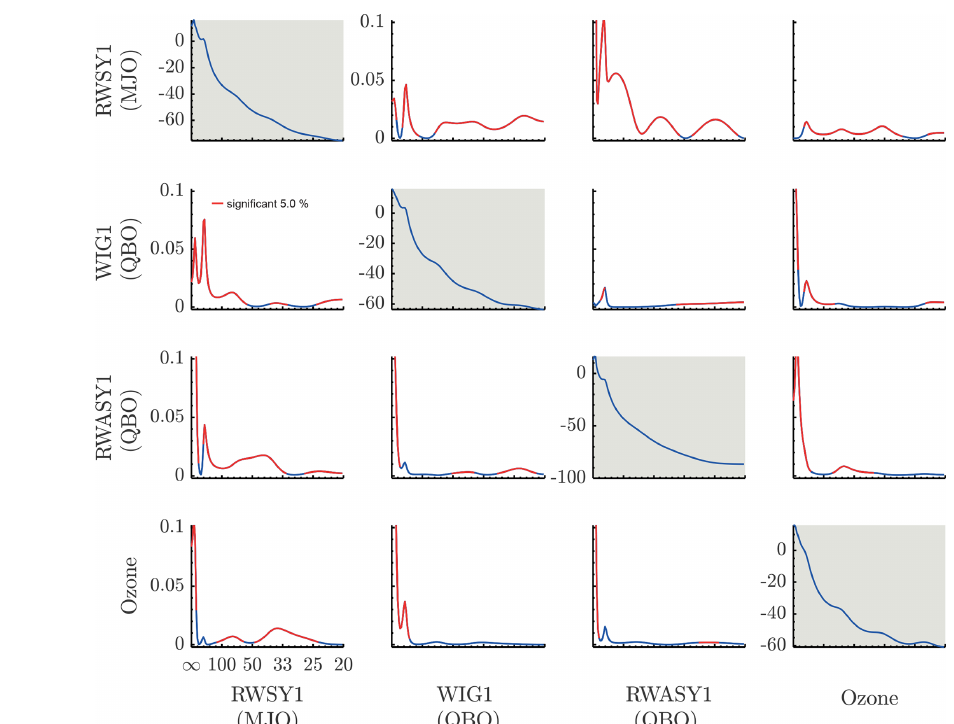
Figure 4. PDC analysis of the interaction of Kelvin, asymmetric Rossby, and westward gravity modes with ozone at the fast timescale (peri- ods given in days). Significant interactions (red curve) between the MJO and ozone as well as QBO-related modes are found on intraseasonal, semi-annual, and annual timescales. Panels in the main diagonal show the power spectral density of each time series. Off-diagonal panels indicate the PDC values between the time series; PDC direction is from the time series indicated in the column to the one indicated in the row. For each panel, the x axis represents the frequency and y axis the value of the PDC. Red lines represent the PDC values that were statistically